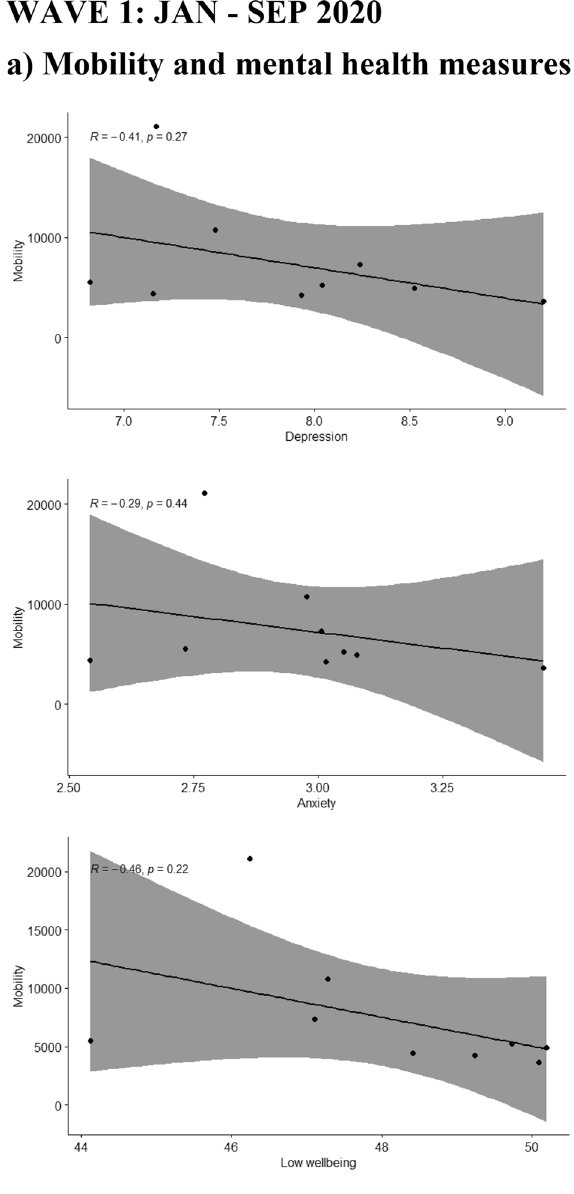
Figure 2. Scatterplots where the mean of Edinburgh Postnatal Depression Scale (EPDS) (depression), EPDS-3A (anxiety) and WHO-5 (wellbeing) are plotted with ( a ) mobility (monthly median distance away from home), ( b ) Google searches (weekly relative interest in the pandemic based on searches of “corona”) during the same and the previous week (lagged searched), and ( c ) weekly number of deaths (attributed to COVID-19) during the same and the previous week, separately in wave 1 and wave 2 of the